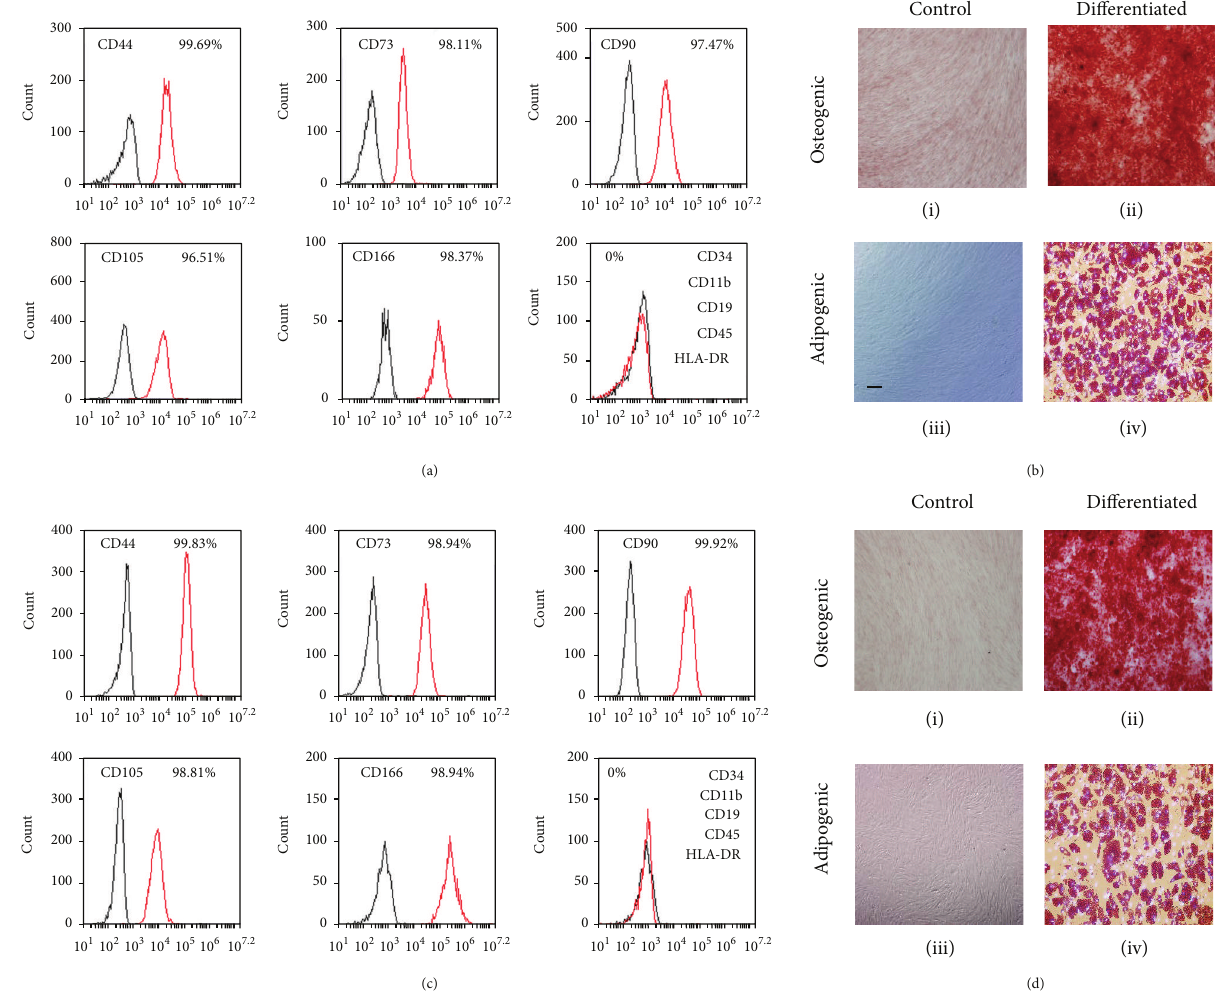
Figure 1: MSCs cultured in PPRF-msc6 with Cohn-fractionated albumin containing media (a) or DMEM 10% FCS (c) were analyzed for markers using flow cytometry. Cells grown in either medium were positive for CD44, 73, 90, 105, and 166 and negative for CD34, 11b, 19, 45, and HLA-DR. MSCs could differentiate into both osteoblasts and adipocytes when grown in either PPRF-msc6 with Cohn-fractionated albumin (b) or DMEM 10% FCS (d). Osteogenic calcium containing matrix laid down is stained with alizarin red (ii) while control (i) is negative. Lipid droplets in the adipocytes are stained with oil red-O and nuclei with Hoechst-33342 (iv) and are absent in the control (iii). Bar is equal to 100 𝜇